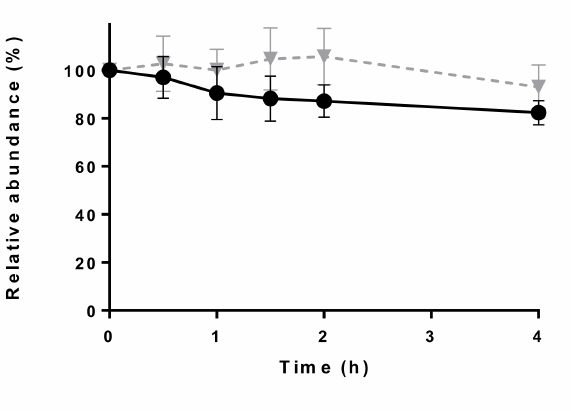
Figure 1. Degradation of a 1 µ g mL − 1 cefquinome solution in ultra high-performance liquid chromatography-water (UHPLC-water) (- (cid:72) -) and a 1 µ g mL − 1 ceftiofur ( • ) working solution in dimethyl sulfoxide/UHPLC-water (1/1000; v / v ) (mean ± standard deviation) at room temperature (21 ± 2 ◦ C; n = 3).